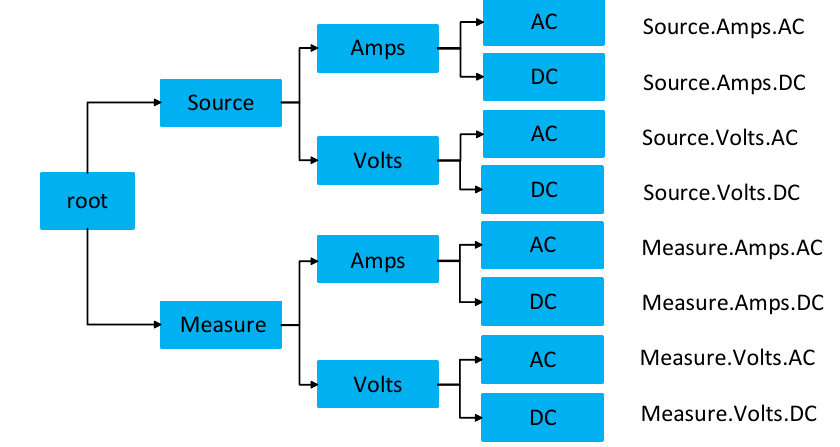
Figure 6. An example measurement